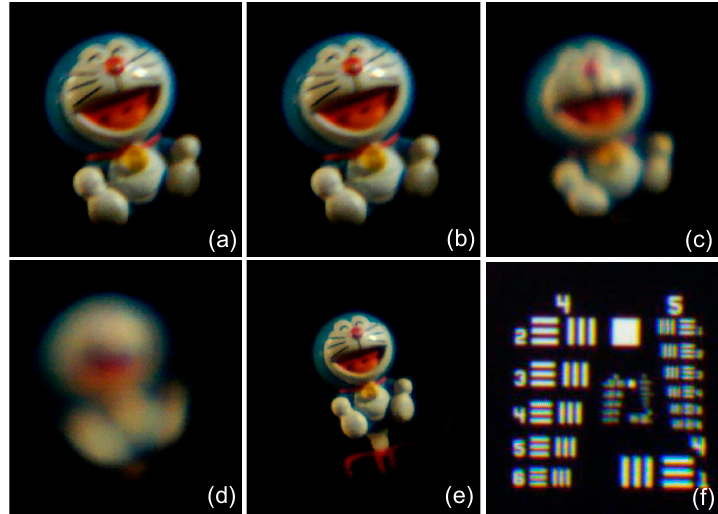
Figure 3. Image of a toy observed through the liquid lens at various voltages. ( a ) V = 0, ( b ) V = 18 V rms , ( c ) V = 30 V rms , ( d ) V = 45 V rms , and ( e ) refocus at V = 45 V rms , ( f ) image of resolution target at V = 0.